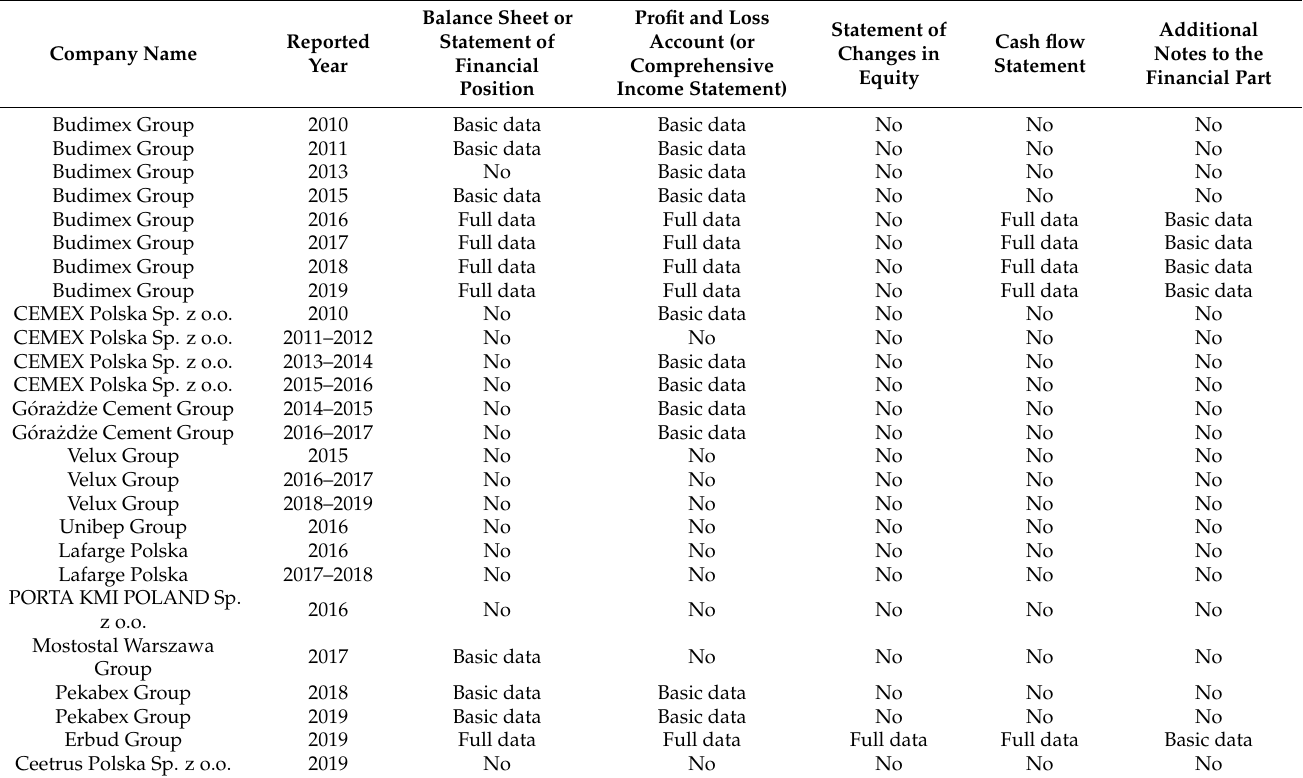
Table 3. Financial information in the analysed CSR and integrated